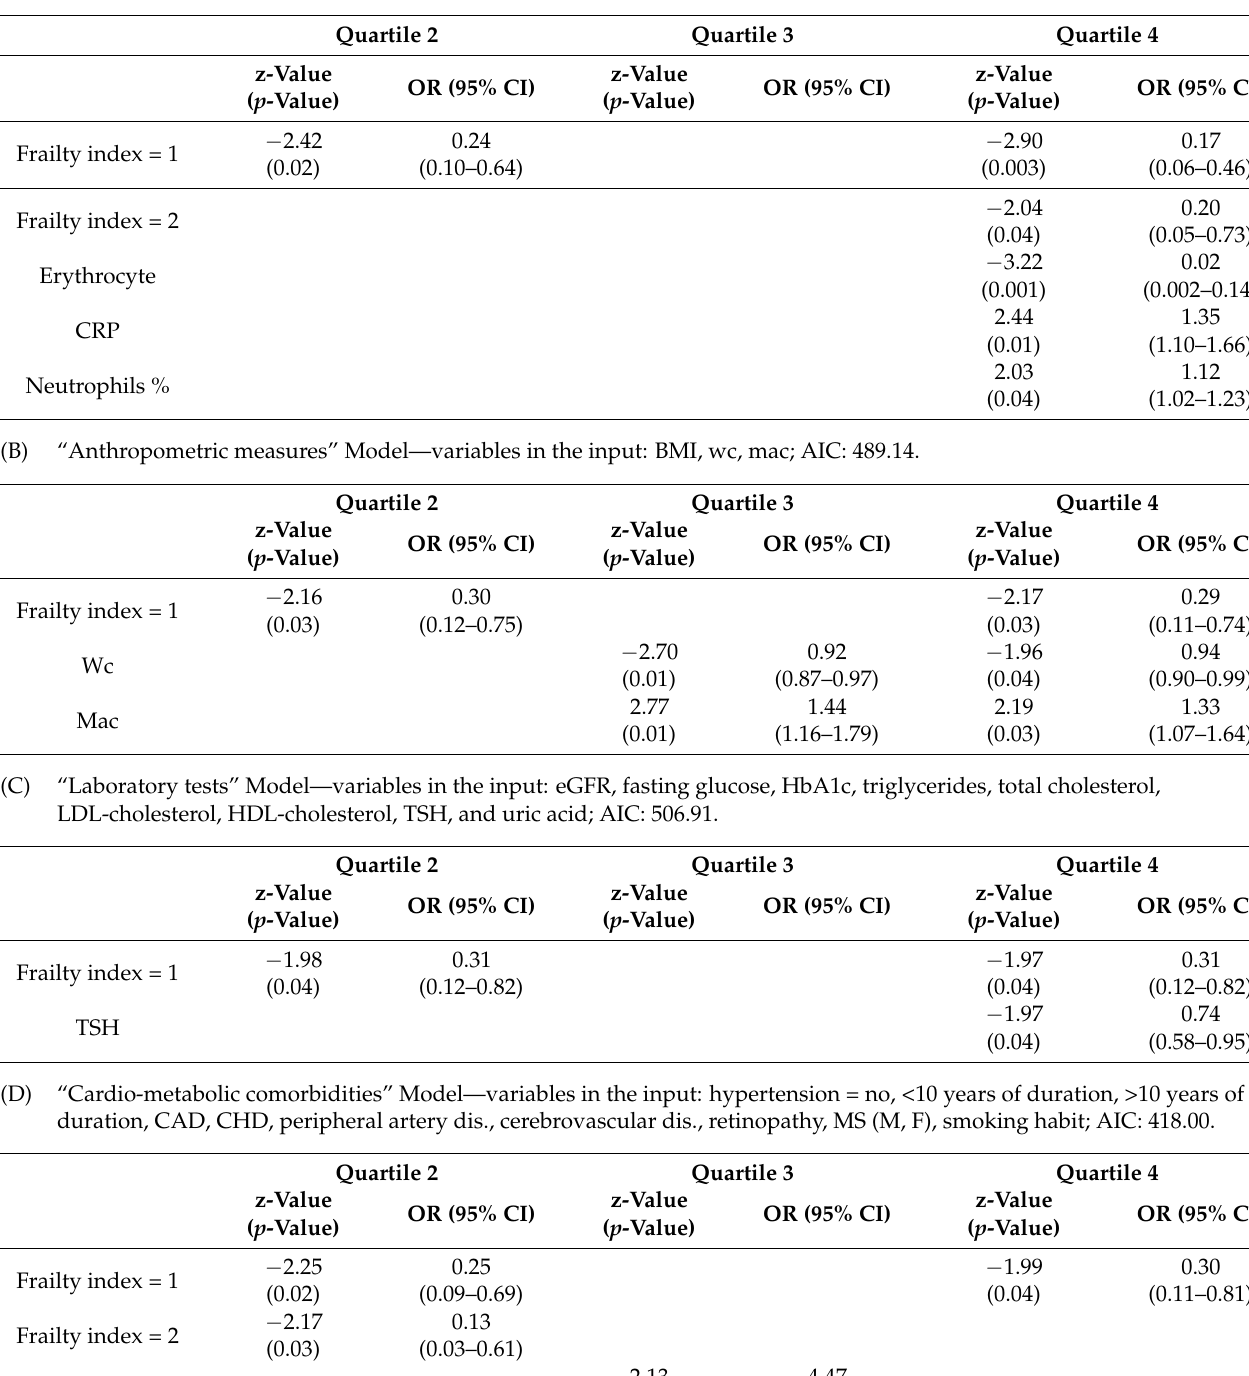
Table 3. Multinomial logistic regression models for quartiles of IL-37. All models were adjusted for age, gender, T2D duration, and the frailty index. The tables visualized only variables marked as important by the respective regression model ( p -value lower than